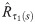
Optimal window selection using APE.(A) An observed incidence curve (blue dots) is sequentially and causally predicted over time s ≤ t using effective reproduction number estimates based on two possible windows lengths of k1 and k2 (blue shaded). Predictive distributions are summarised by red error bars (shown only for times t1 and t2, respectively for k1 and k2), (B) The true reproduction number (Rs, dashed black) is estimated under each window length as R^τ1(s) (blue) and R^τ2(s) (grey). Large windows (k1) smooth over fluctuations. Small ones (k2) recover more changes but are noisy. (C) The APE assesses k1 and k2 via the log-loss of their sequential predictions (i.e. from red error bars across time). The window with the smaller APE is better supported by this incidence curve. See Methods for more mathematical details.